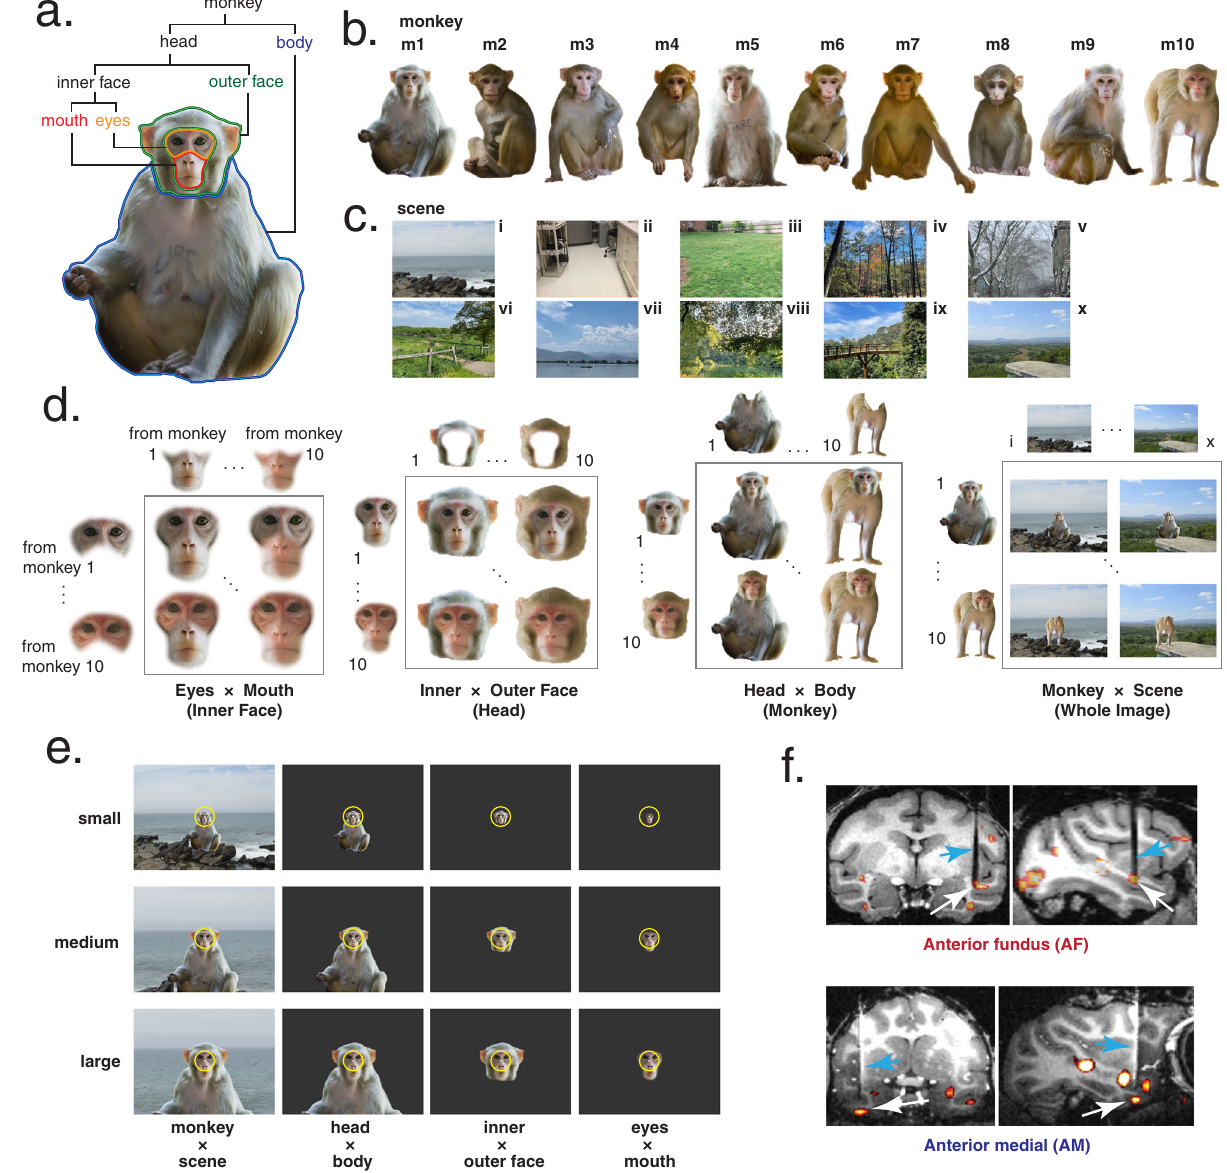
Fig. 1 | Recombined partsstimuli. a Photograph of one macaque monkey broken down into component parts. Eyes and mouth compose the inner face, outer and inner face compose the head, and body and head compose the full monkey. Macaque images were obtained from https:// fi gshare.com/articles/dataset/ Macaque_Faces/9862586/1 under a CC-BY 4.0 license. b Example high-resolution photos of front-facing macaques which form the basis of the stimulus